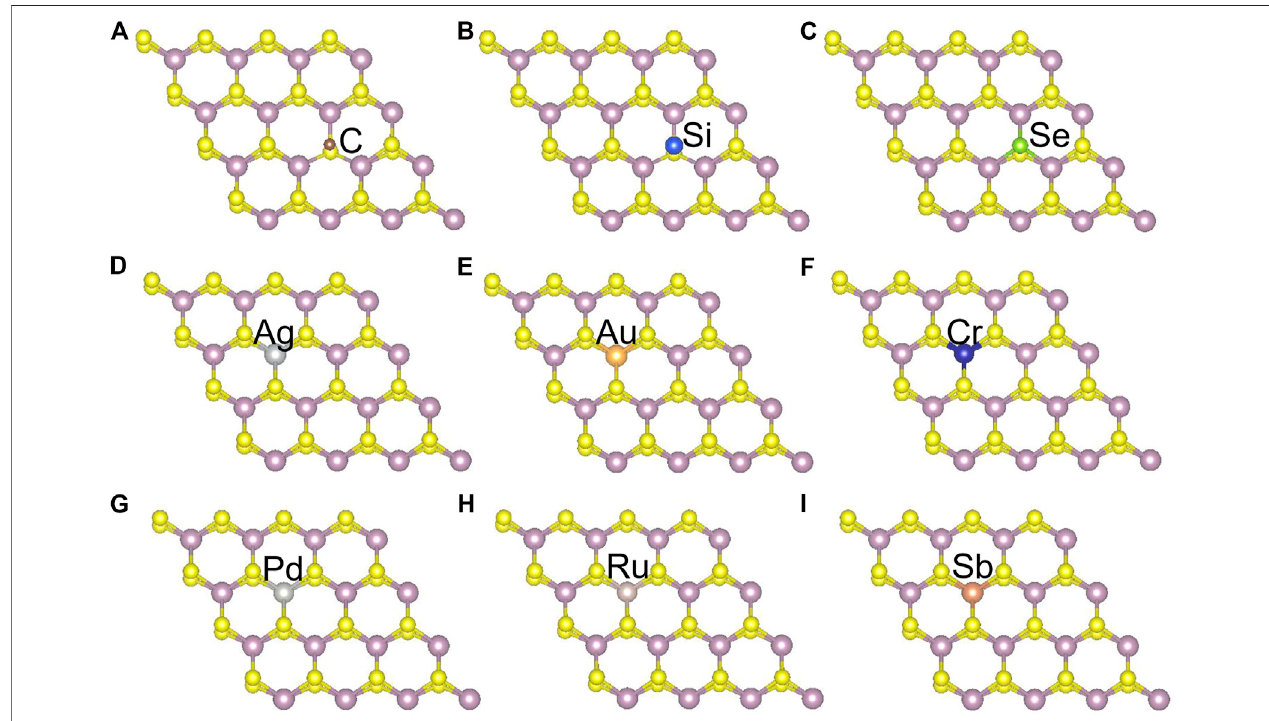
FIGURE10| Monolayer2H-MoS2structuredopedwithdifferentforeignatoms: (A – C) thesubstitutionofaSatomwithC,Si,andSeatoms,respectively; (D – I) the substitution of a Mo atom with Ag, Au, Cr, Pd, Ru, and Sb atoms, respectively.